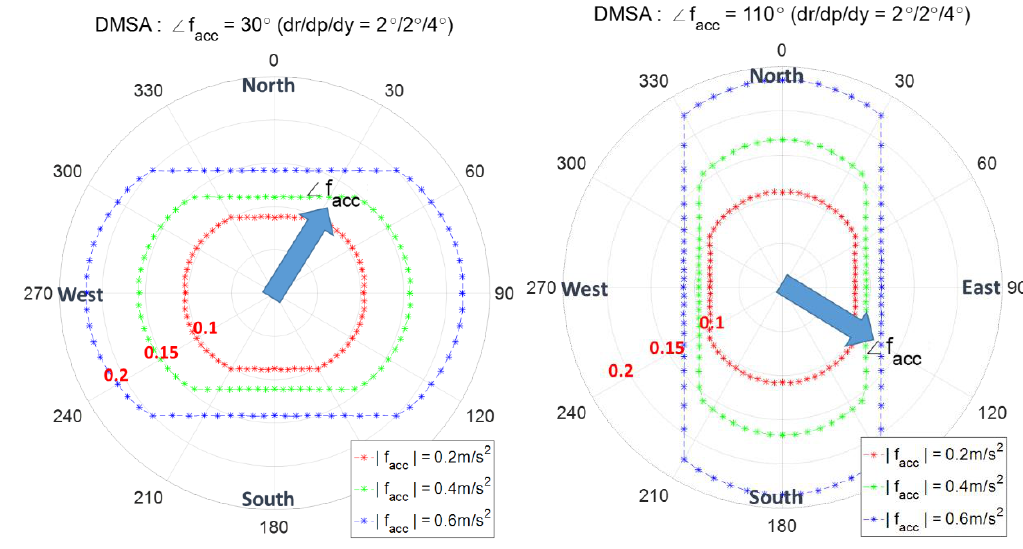
Figure 16. Combined contour of DMSA with respect to the magnitude of 𝐟 𝐚𝐜𝐜 .